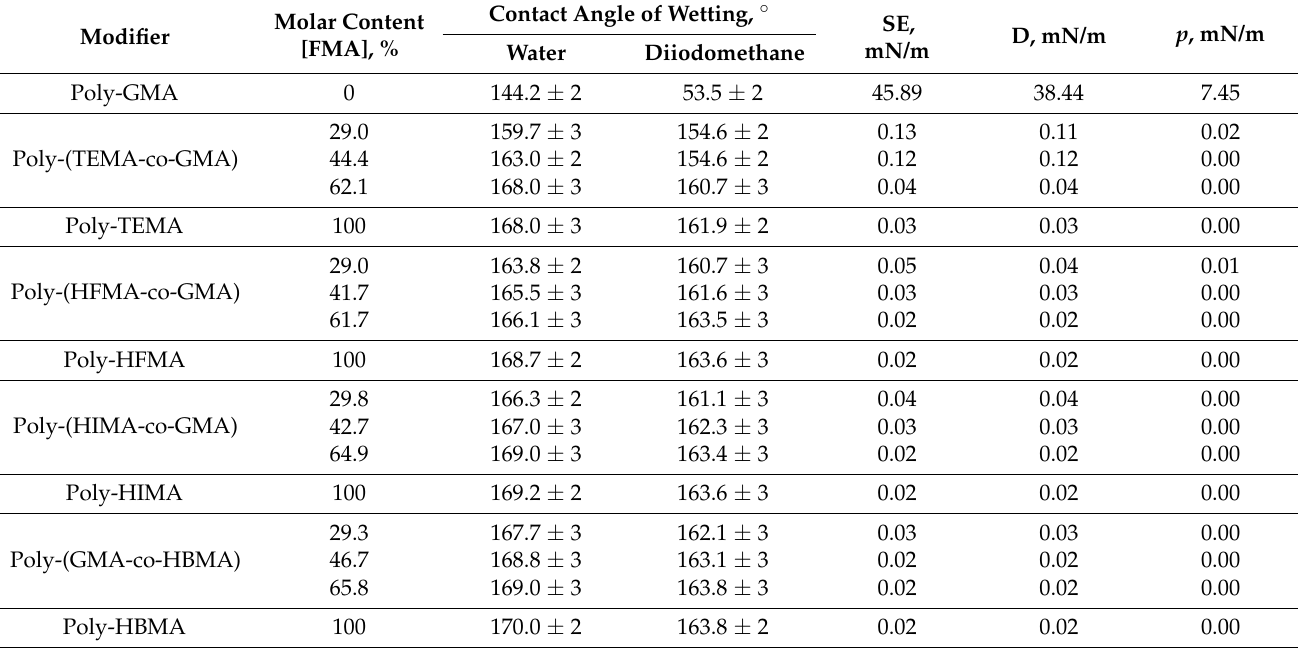
Table 4. Initial contact angles and surface free energy of textured aluminum modified with GMA- and FMA-based copolymers with different monomer unit